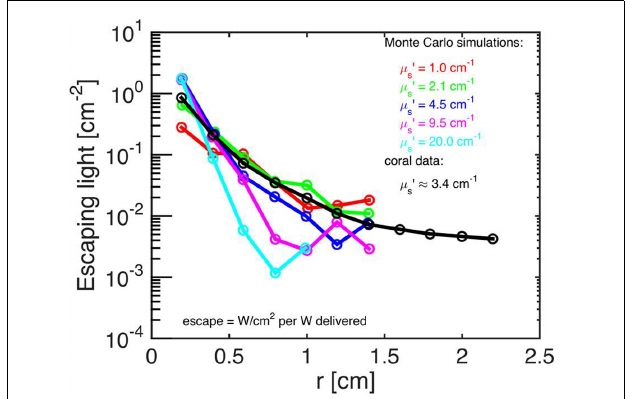
visible range (Jacques, 2013). The Monte Carlo simulations